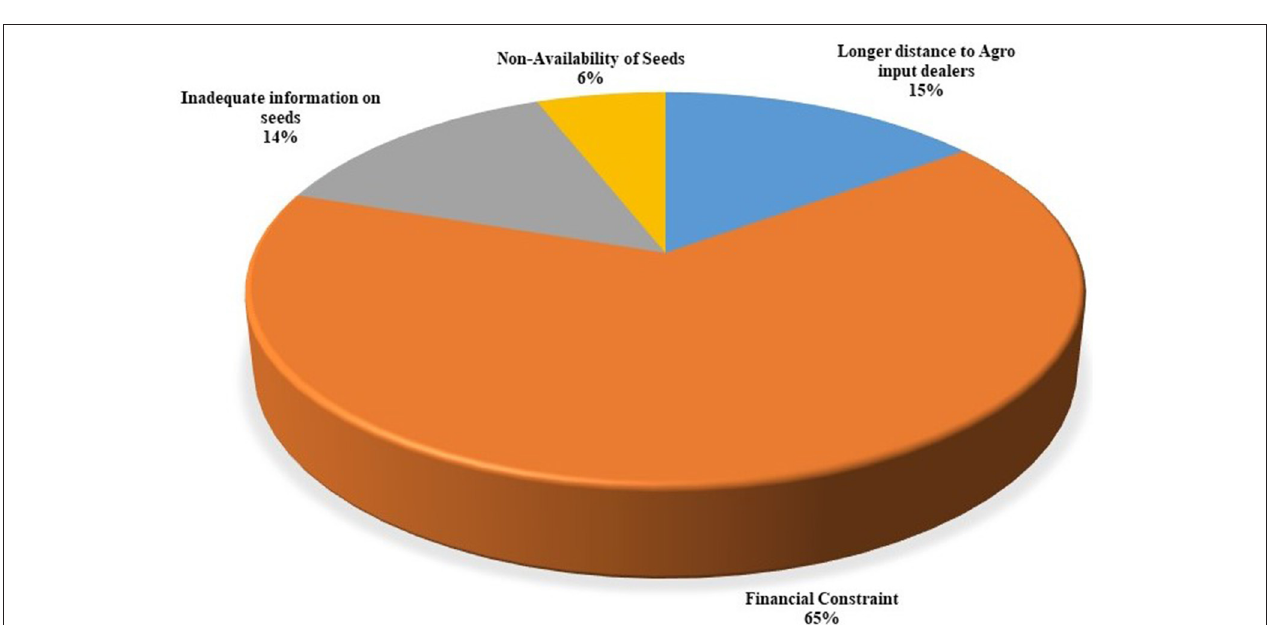
FIGURE 6 | Distribution showing why farmers will discontinue using improved